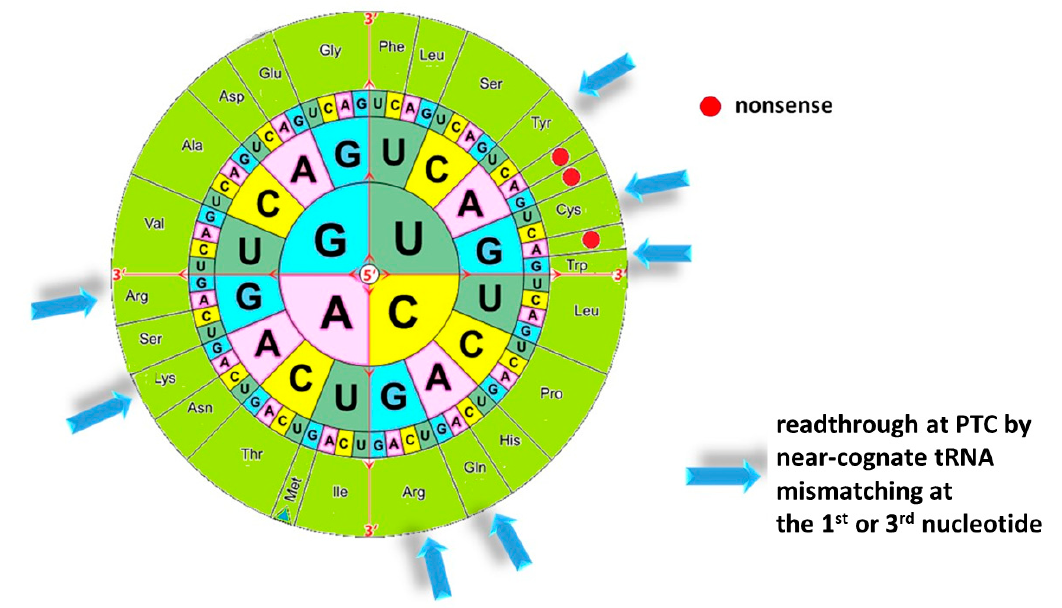
Figure 1. Codons language and most frequent misreadings for premature termination codon (PTC)’s readthrough.